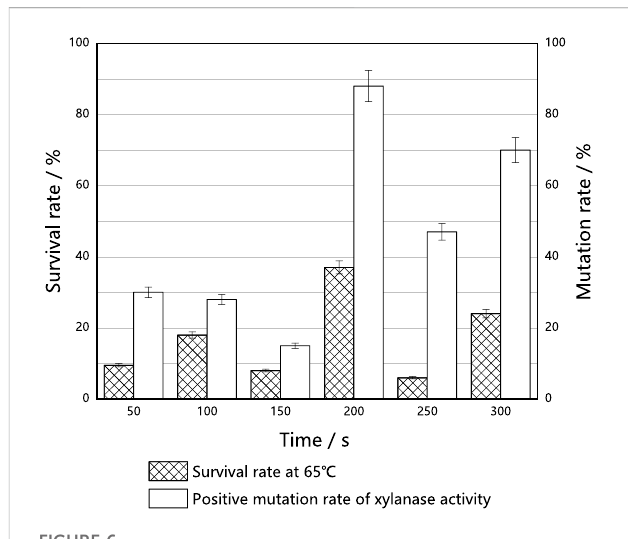
Effect of ARTP implantation time on the thermostable of M. thermophila. For M. thermophila , the optimum temperature was 60 ° C. On this basis, raised the culture temperature to 65 ° C. The effects of different ARTP implantation times on the survival rates of M. thermophila were investigated , and the xylanase activities of the surviving mutants were determined. The mutation rate was de fi ned as the xylanase activity higher than 5% of the original strain. All experiments were carried out four times (biological duplicates and technical duplicates) and mean values presented with standard